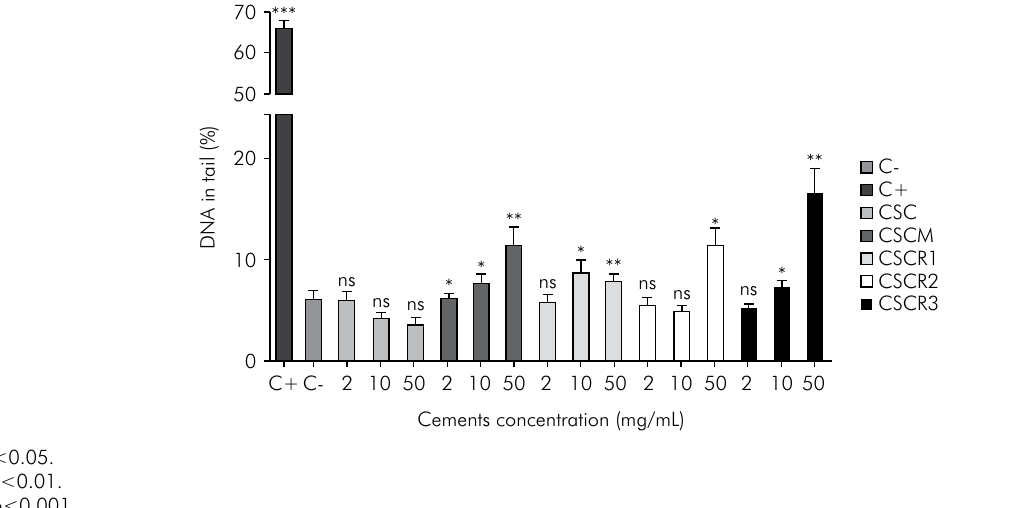
*p <0.05. **p <0.01. ***p<0.001. Figure 2. Genotoxicity represented by % of DNA in the tail, in the SAOS-2 cell lineage treated with eluates of 50, 10 and 2 mg/mL for 24 hours. C-: Negative control (untreated cells), C+: Positive control (1mM of hydrogen peroxide for 10 min). Results are expressed as a % of DNA in the tail of 100 cells per concentration and controls, and analyzed by Kruskal-Wallis, with the Dunn posttest (treated vs.